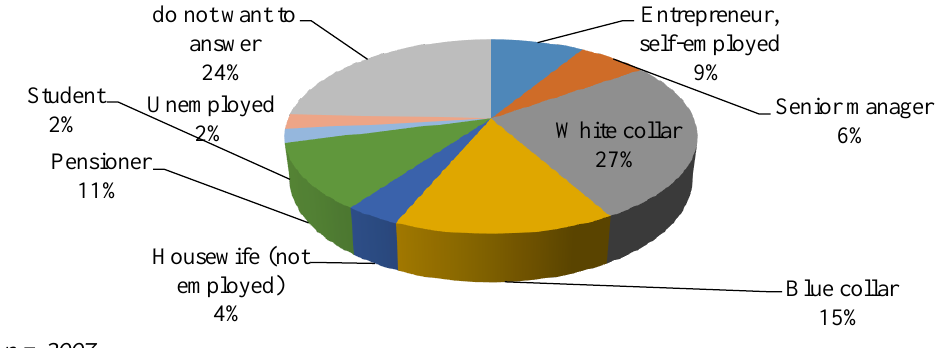
Fig. 3. Respondents’ principal (main activity).